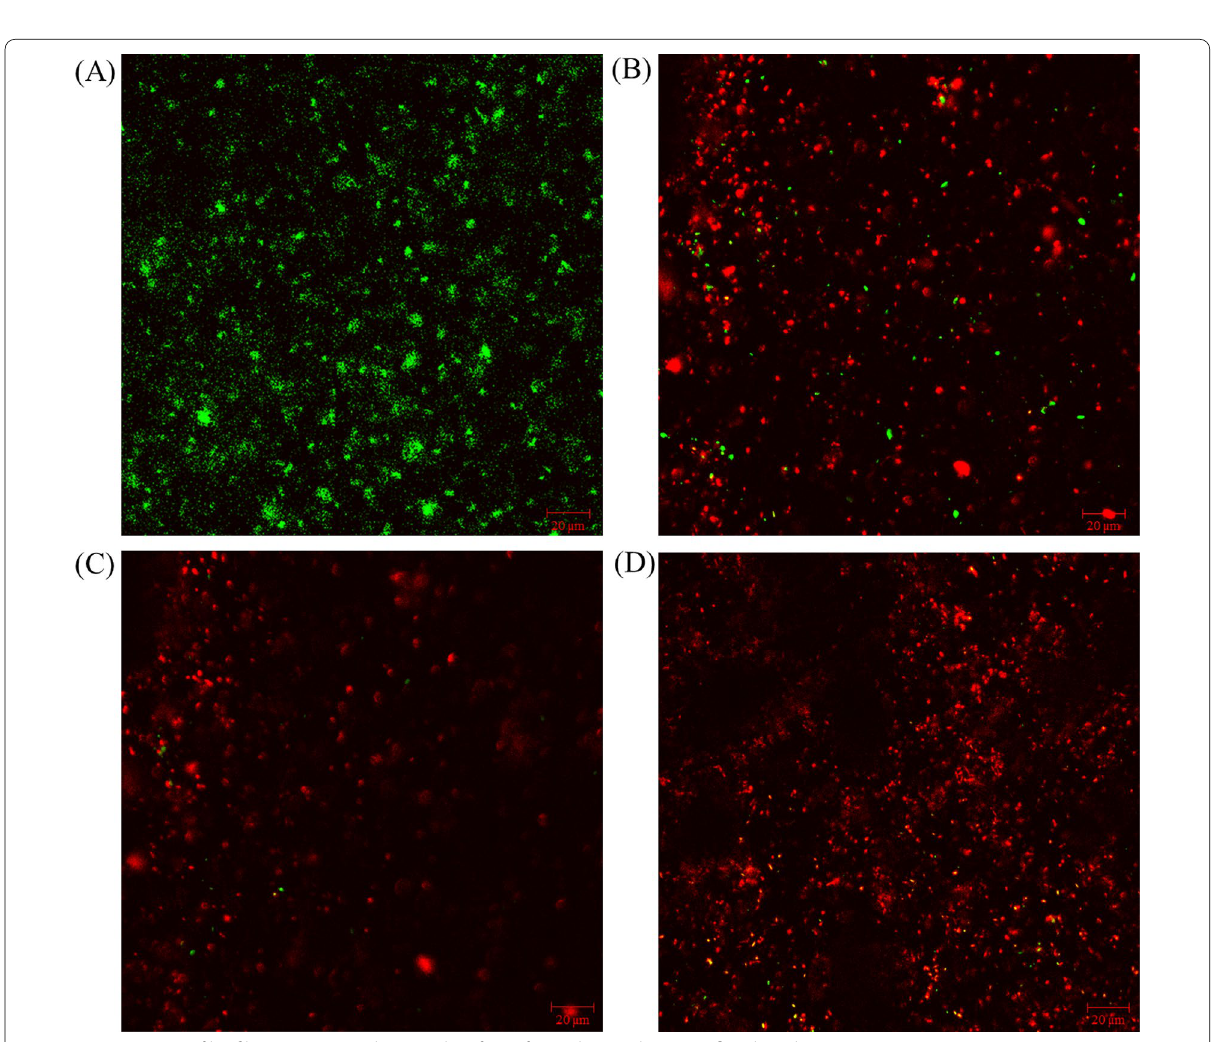
Fig. 6 CLSM images of biofilm on C1018 carbon steel surface after 7-day incubation in flow loop bioreactors: A no treatment, B 50 ppm THPS, C 50 ppm THPS 100 nM Peptide A, D 100 ppm +